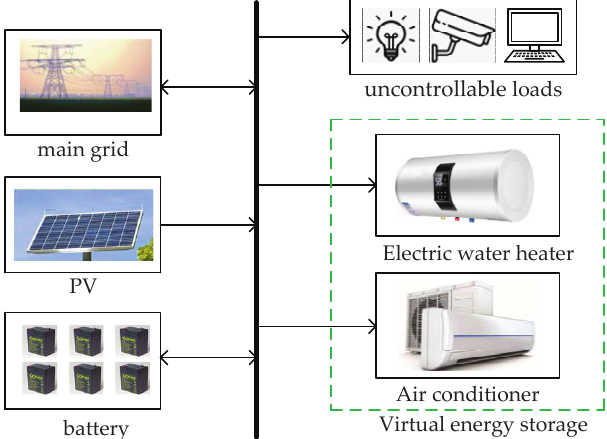
Figure 1. The structure of building integrated photovoltaic (BIPV) microgrid